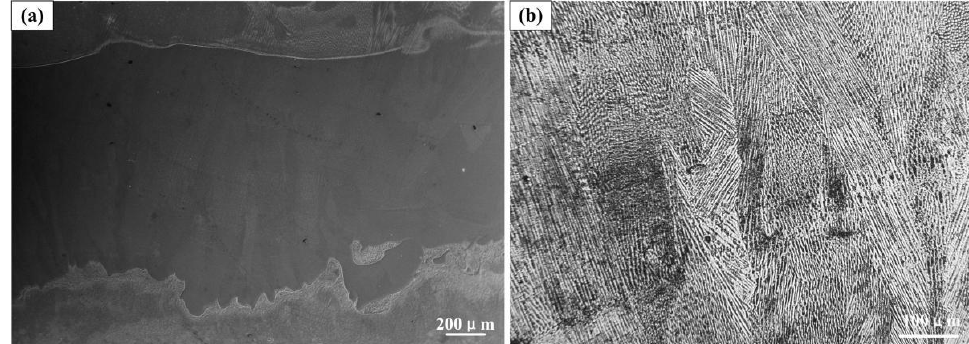
Figure 6. Microstructure diagram from Ni layer to Cu matrix: ( a ) microstructure of Ni-Cu layer; ( b ) enlarged view of Microstructure of Ni-Cu layer.